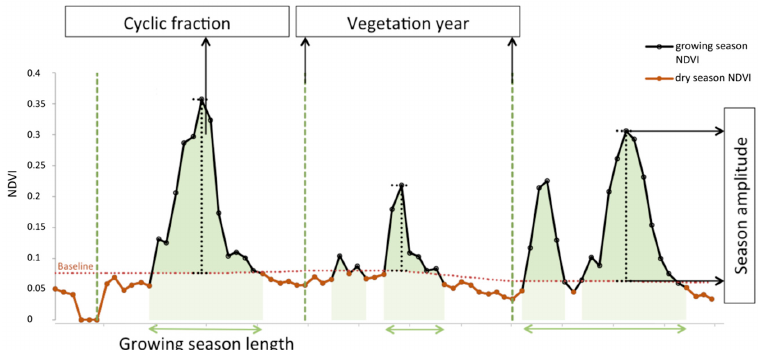
Figure B1. Overview of the principle and terminology used in the phenological parameterization model to derive vegetation productivity proxies (cyclic fraction). One time step represents 14 days.